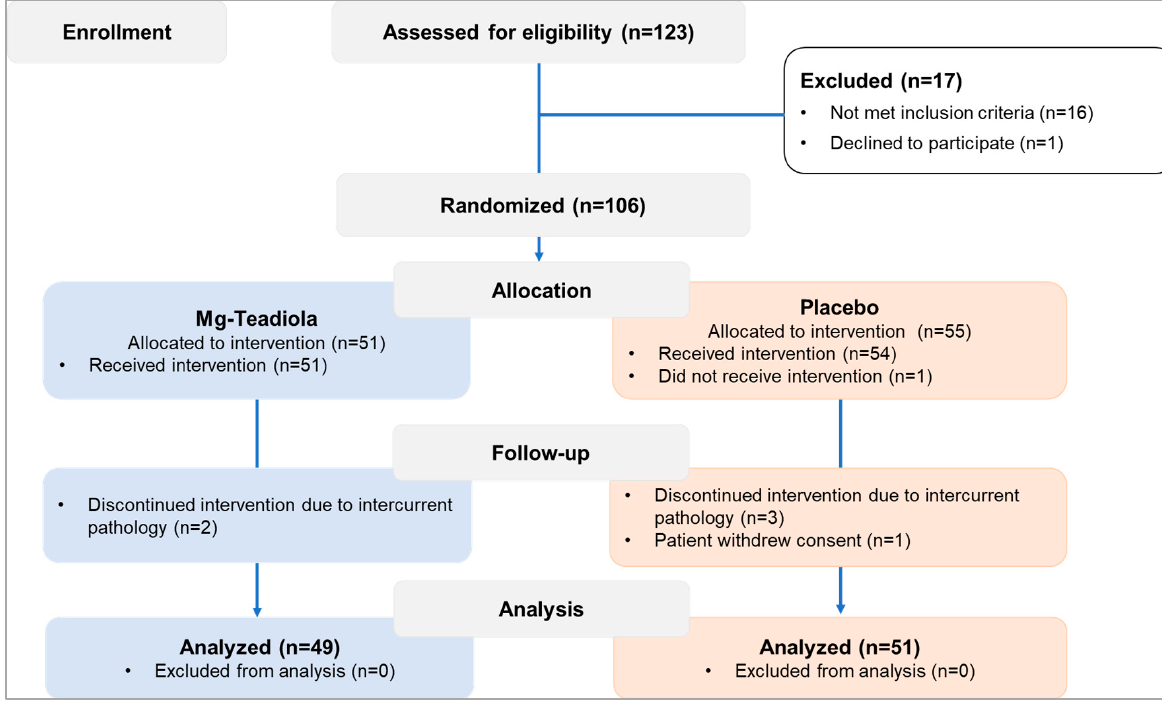
Figure 2. Patient disposition. Mg-Teadiola, combination of 150 mg magnesium, 0.7 mg vitamin B6, 0.1 mg vitamin B9, and 1.25 µg vitamin B12, + 222 mg of rhodiola extract and 125 mg of green tea extract including 50 mg of L-theanine.